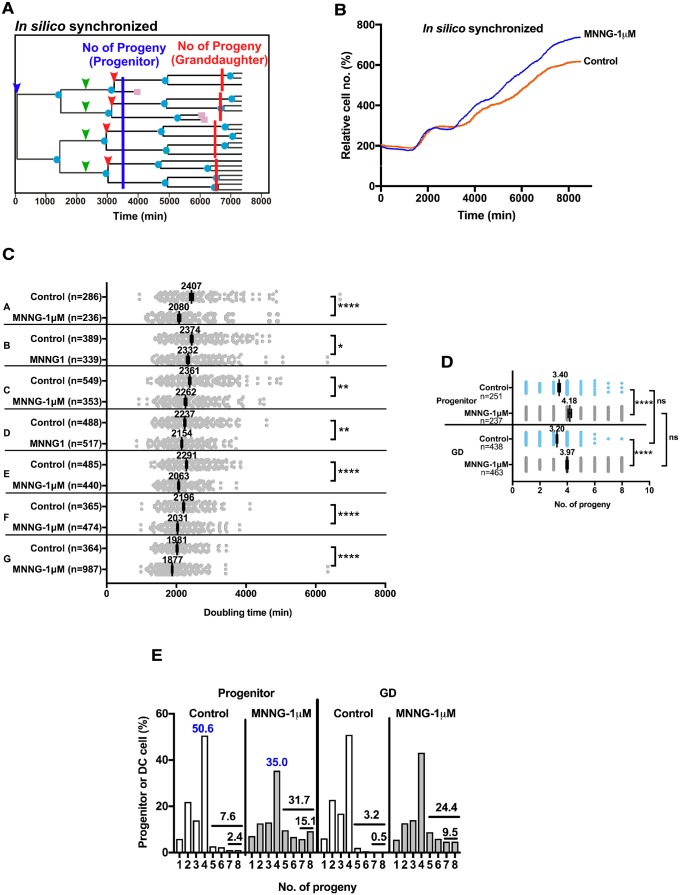
Analysis of progeny produced from Control and MNNG-1μM-exposed cells.A. The cell cycle was synchronized in silico. The time point when the progenitor cells divided was normalized as Time 1 (blue arrowhead). Blue line indicates the time point 3500 min after the division. GD cells are indicated by green arrowheads. The red line shows the time point 3500 min after the division of GD cells (red arrowheads). B. Cell growth curves determined after synchronization. C. Progenitor cells were grouped (A-G) according to the numbers of progeny cells, as shown in Table 2. Each group was composed of at least 200 cells. The cell doubling times of each group of cells were then determined to perform Welch’s t-tests; ns: not significant, and *p<0.05, **p<0.01 and ****p<0.0001 in relation to Control. Results shown as the mean ± SEM. An in silico synchronized-cell lineage database was used. D and E. The numbers of progeny produced from a progenitor at 3500 mins and from GD cells at 3500 min from their cell division were determined. D. One-way ANOVA (Tukey’s multiple comparison test) was performed; ns: not significant, and ****p<0.0001. Results shown as the mean ± SEM. E. The numbers of progenitor and GD cells producing 1–8 progeny cells are shown. The vertical scale represents the percentage of progenitor or GD cells producing 1–8 progeny cells. The values shown in the figure represent progenitor cells that produced 4 progeny (blue), and the percentages of the total numbers of progenitor and GD cells that produced 5, 6, 7, and 8 (upper line) and 7 and 8 progeny (lower line).